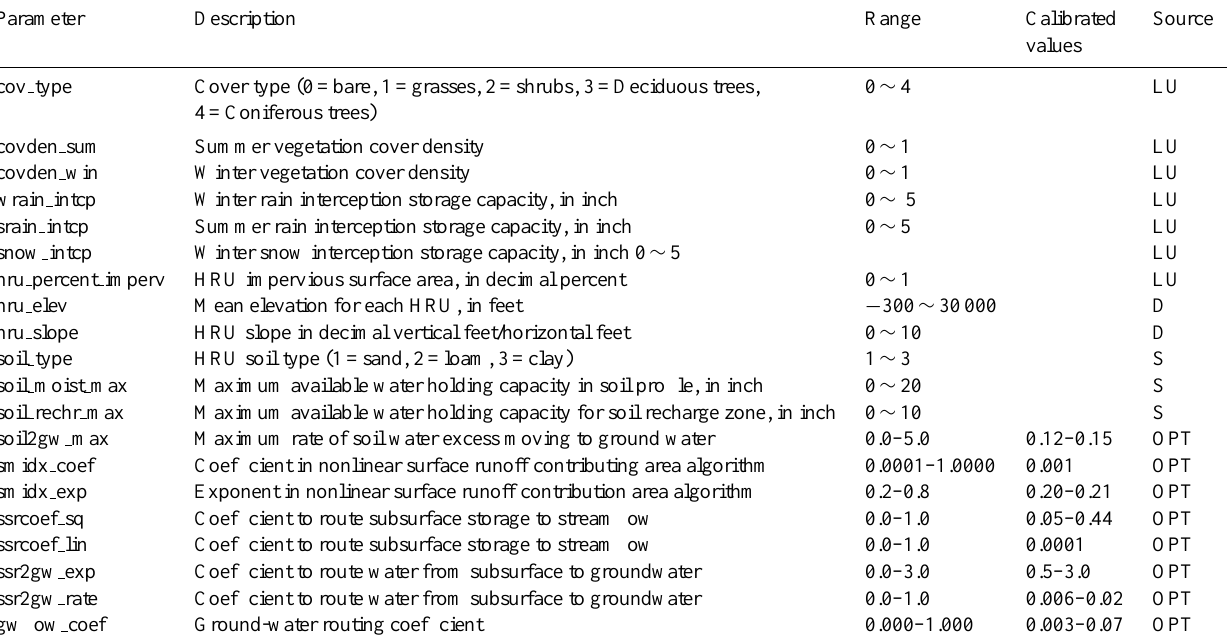
Table 1. PRMS model parameters for calibration. D: Digital elevation map, LU: Land use map, S: Soil map, OPT: Optimized (modified from Chang et al.,